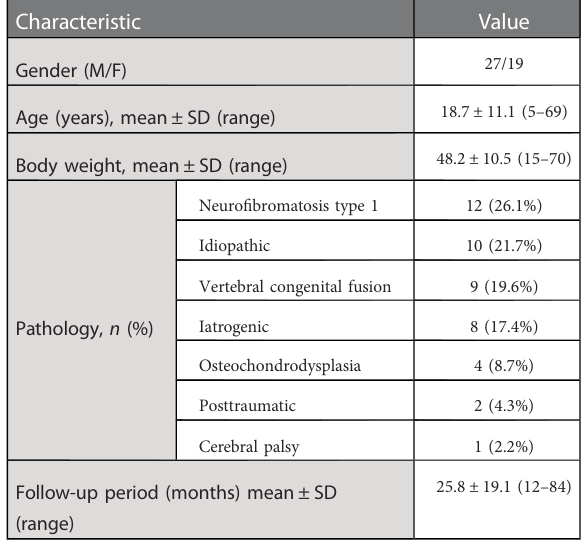
TABLE 2 Patient demographic data N =46. Characteristic